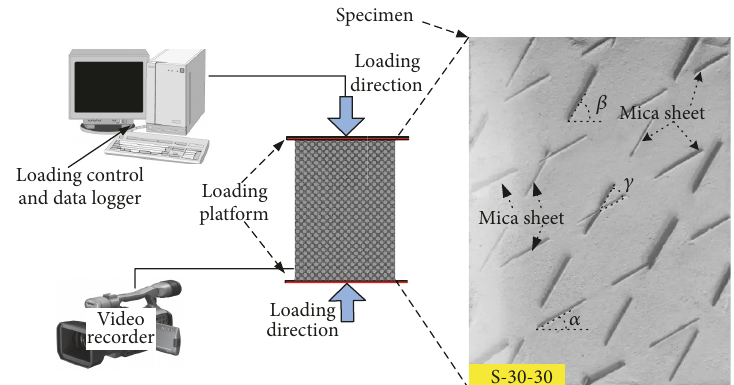
Figure 3: The layout of the loading system.